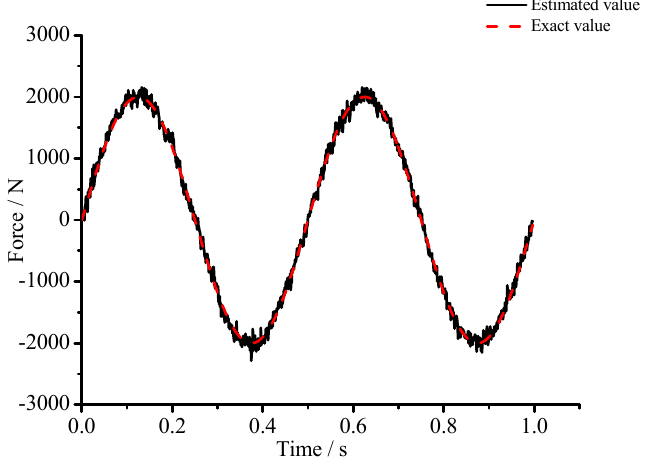
− 3 , σ = 1 × 10 − 6 ). w = 1 × 10